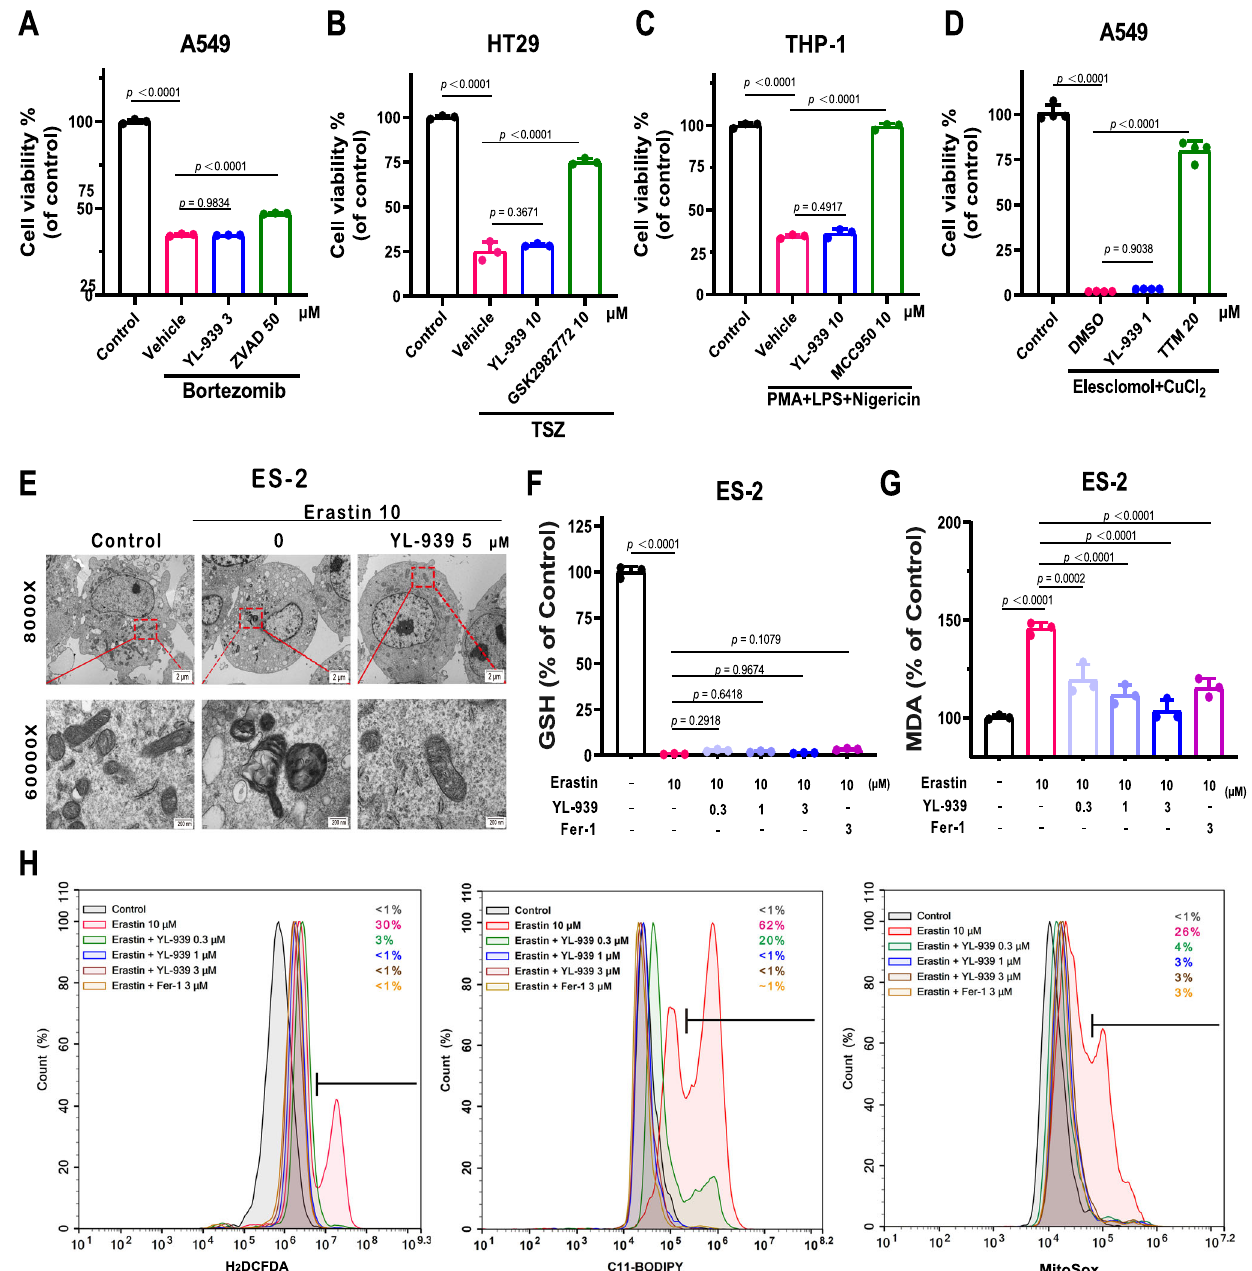
Fig.3|YL-939speci fi callyprotectedcellsfromferroptosis.A EffectofYL-939on the bortezomib-induced A549 cell apoptosis model. ZVAD was used as a positive compound.Data represent the mean±SDof three biological replicates. B Effectof YL-939 on the HT29 cell necroptosis model induced by TNF α (10ngmL − 1 ), Smac- mimetic (100nM), and Z-VAD-FMK (20mM). GSK2982772 was used as a positive compound.Data represent themean±SDof three biologicalreplicates. C Effectof YL-939 on the cell pyroptosis model induced by phorbol-12-myristate-13-acetate (PMA), lipopolysaccharide (LPS), and nigericin. MCC950 was used as a positive compound.Datarepresentthe mean±SDof three biologicalreplicates. D Effectof YL-939 on the elesclomol/CuCl 2 -induced cuprotosis model.